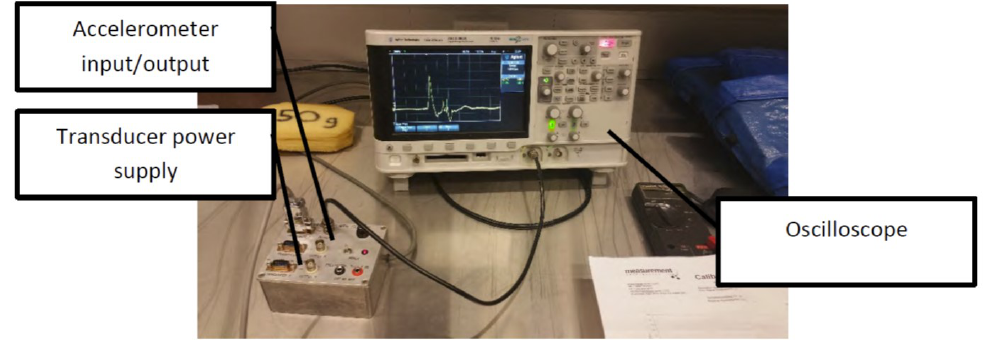
Figure 5. Inertial measurement setup shows the accelerometer output to the oscilloscope through the transducer power supply.